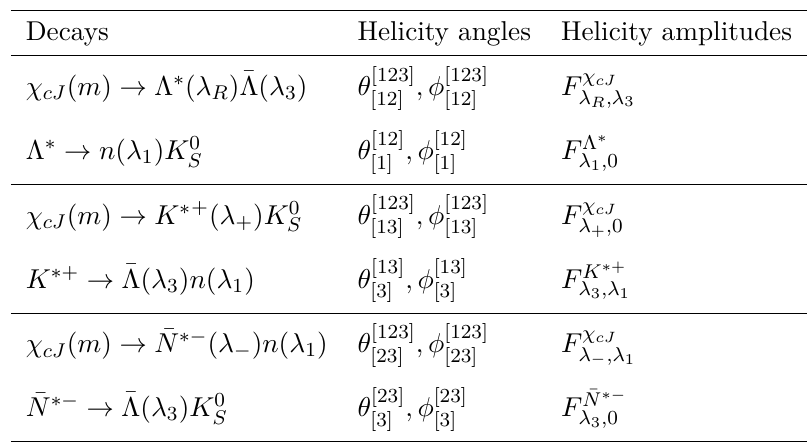
Table 3 . Helicity angles and amplitudes of the sequential decays (a), (b) and (c). λ i denotes the value of helicity for the corresponding particle, and m denotes the spin z projection of virtual photon χ cJ